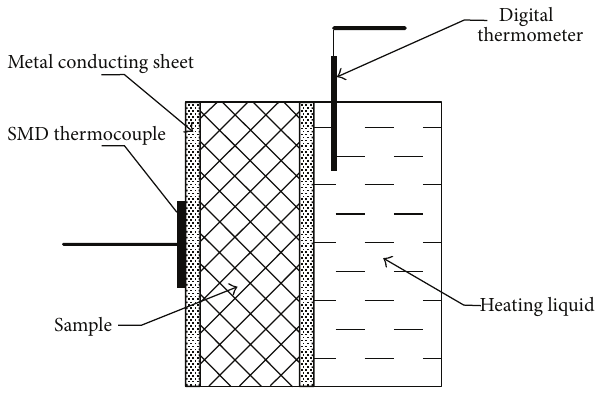
Figure 1: Schematic of setup for thermal insulation